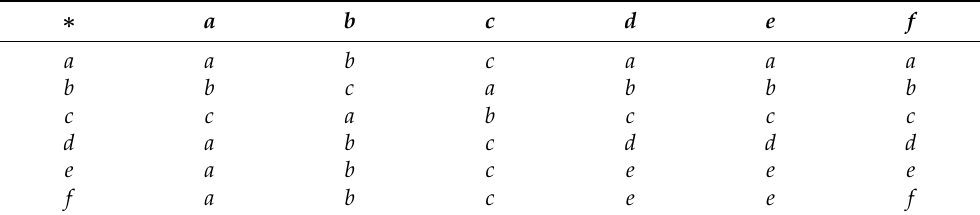
Table 5. A left transposition regular TA-groupoid of Example